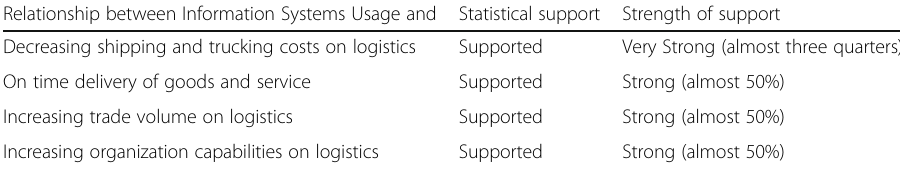
Table 11 Summary of Data Analysis Relationship between Information Systems Usage and Statistical support Strength of support Decreasing shipping and trucking costs on logistics Supported Very Strong (almost three quarters) On time delivery of goods and service Supported Strong (almost 50%) Increasing trade volume on logistics Supported Strong (almost 50%) Increasing organization capabilities on logistics